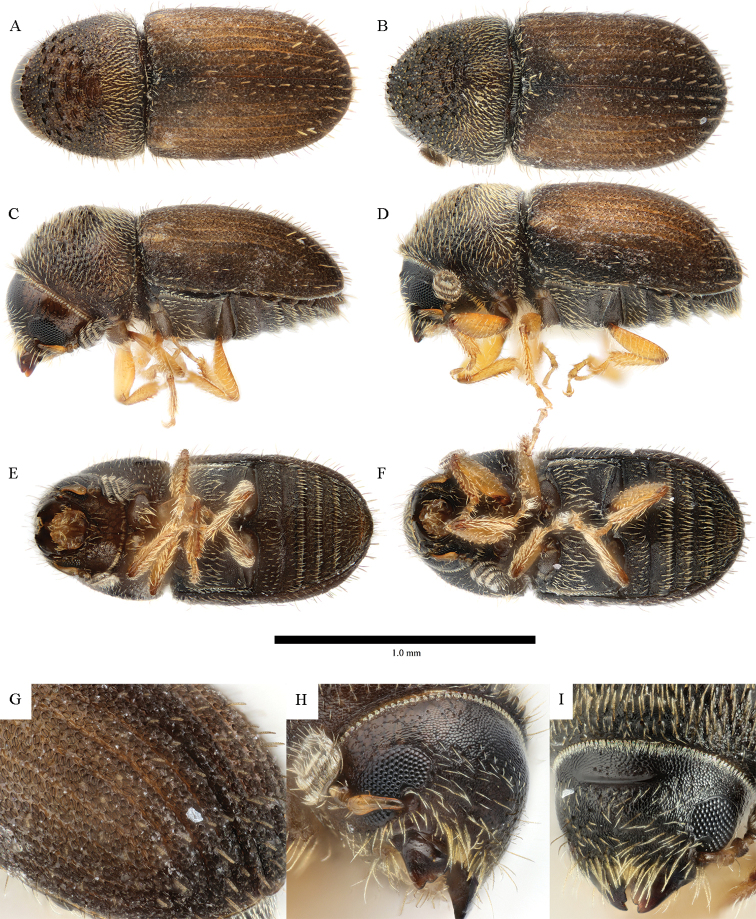
Cryphalus
kyotoensisA, C, E, G, H female UFFE:33170 B, D, F, I male, UFFE:31745.